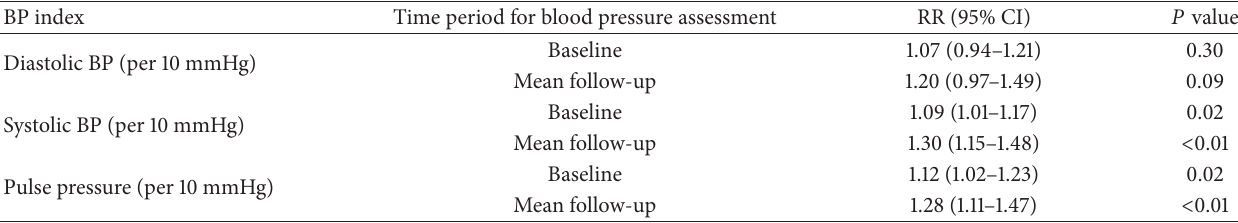
Table 2: Association of CV composite outcome with blood pressure indices.